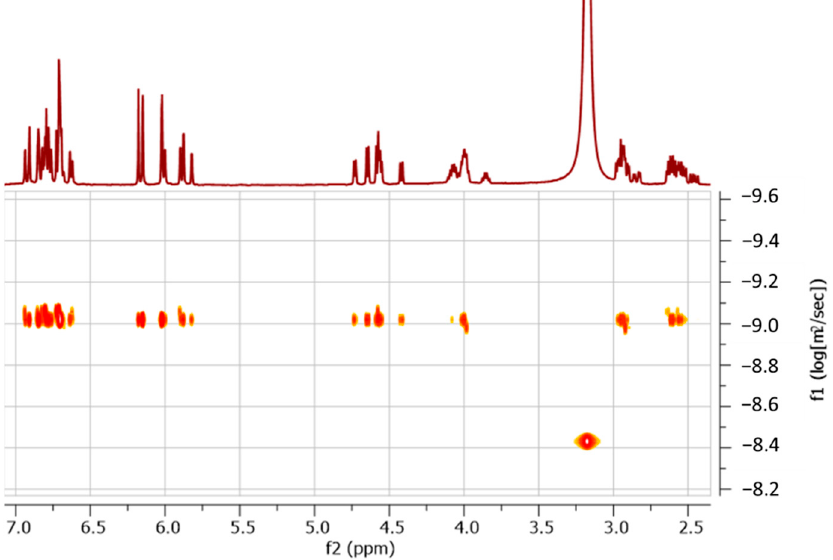
Figure 4. Image of 2D 1 H DOSY spectra of a sample containing both fractions N4 and N2.